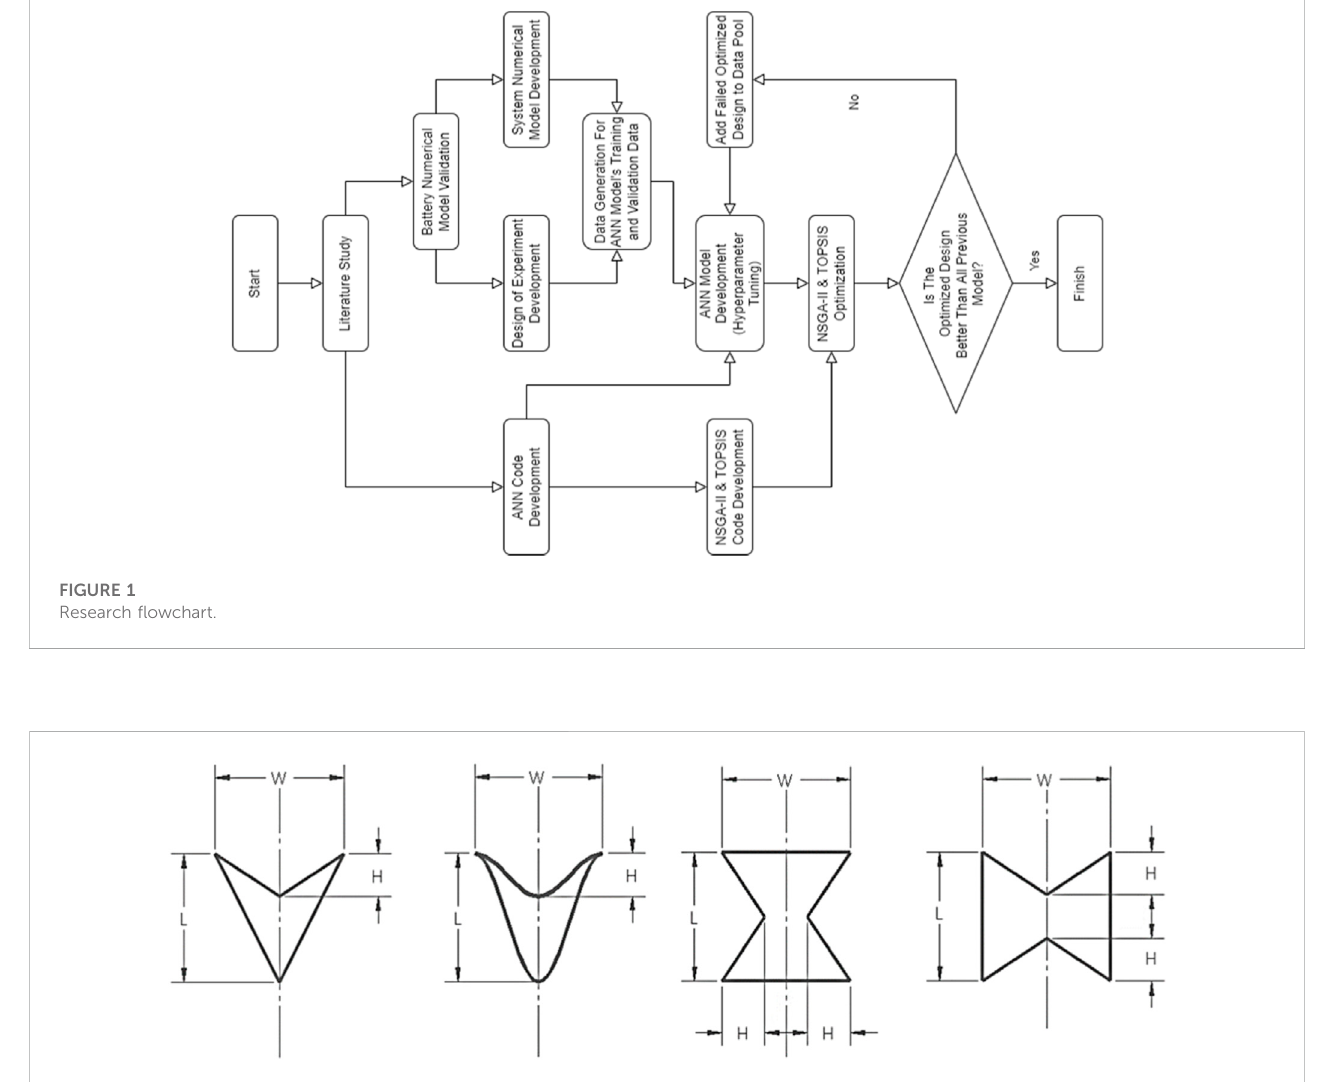
New geometric parameters, from left to right: DA, DU, RE-A,